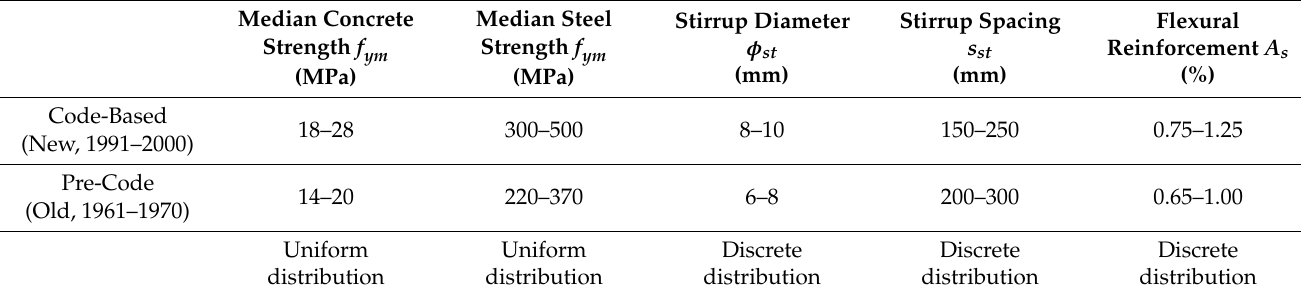
Figure 3. Geometry of the frame typologies. Number of storeys ranges from 1 to 5, while bay spans L i are given in Table 3. Table 3. Global geometry parameters of the frame typologies in Figure 3. Table 4. Ranges adopted for material properties and reinforcement for the two considered